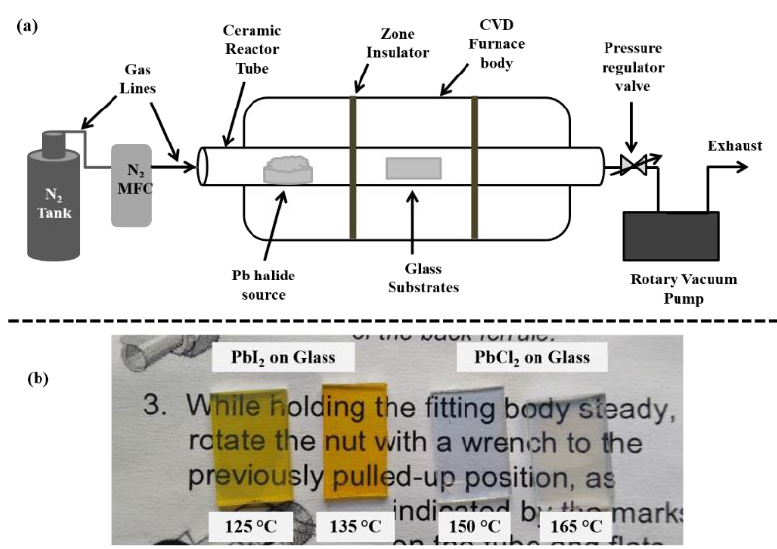
Figure 1. ( a ) Chemical vapor deposition (CVD) system schematic employed here showing all the important components; ( b ) Photographs of the as-deposited Pb halide films on glass at different deposition temperatures as shown (PbI 2 transparent yellow and PbCl 2 transparent white).